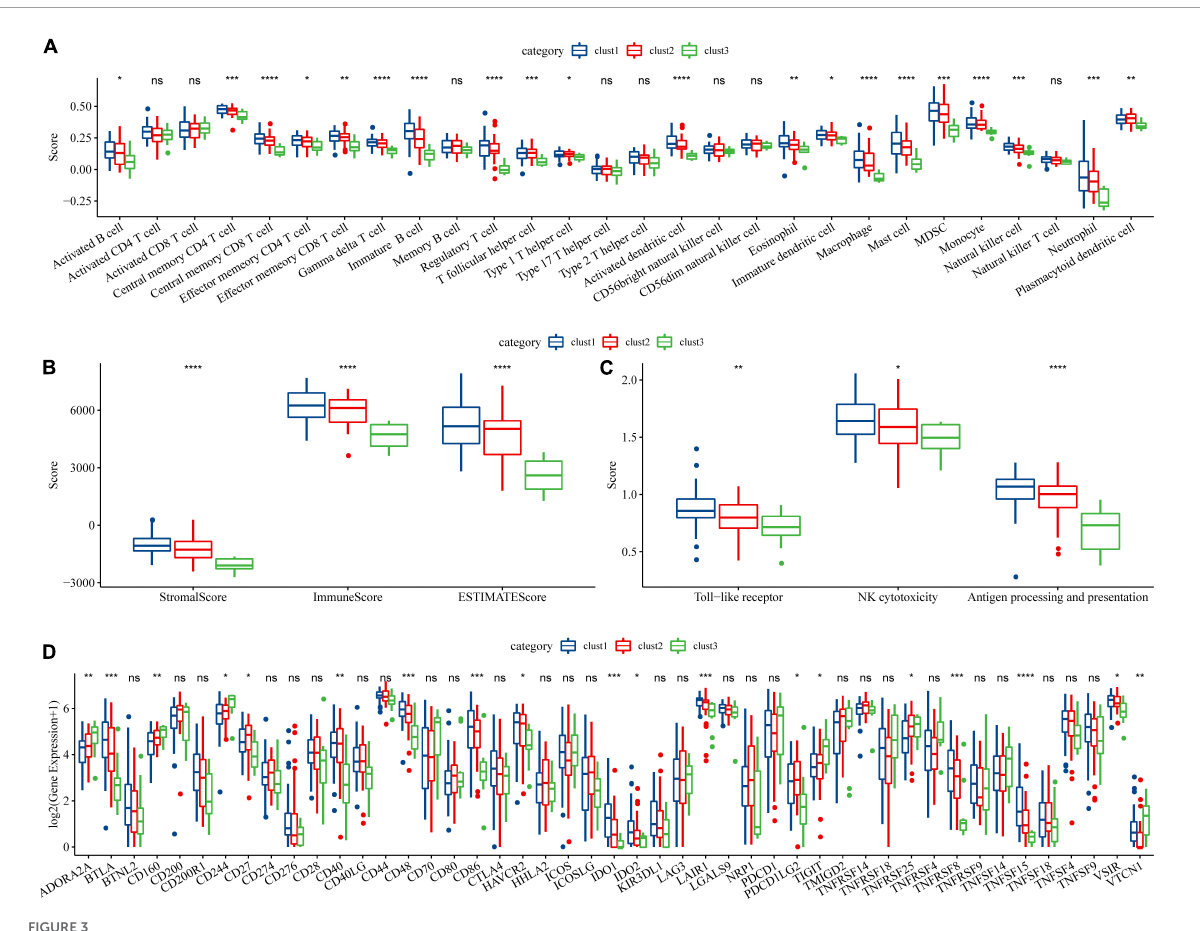
FIGURE3 Immune signature among molecular subtypes of ALL in the Target dataset. (A) Differences of 28 types of immune cell scores between different molecular subtypes; (B) Differences in immune infiltration between different molecular subtypes through ESTIMATE; (C) Differential analysis of macrophage-involved pathways between different subtypes; (D) Differentially expressed immune checkpoints between different subtypes (* P < 0.05; ** P < 0.01; *** P < 0.001; and **** P < 0.0001).